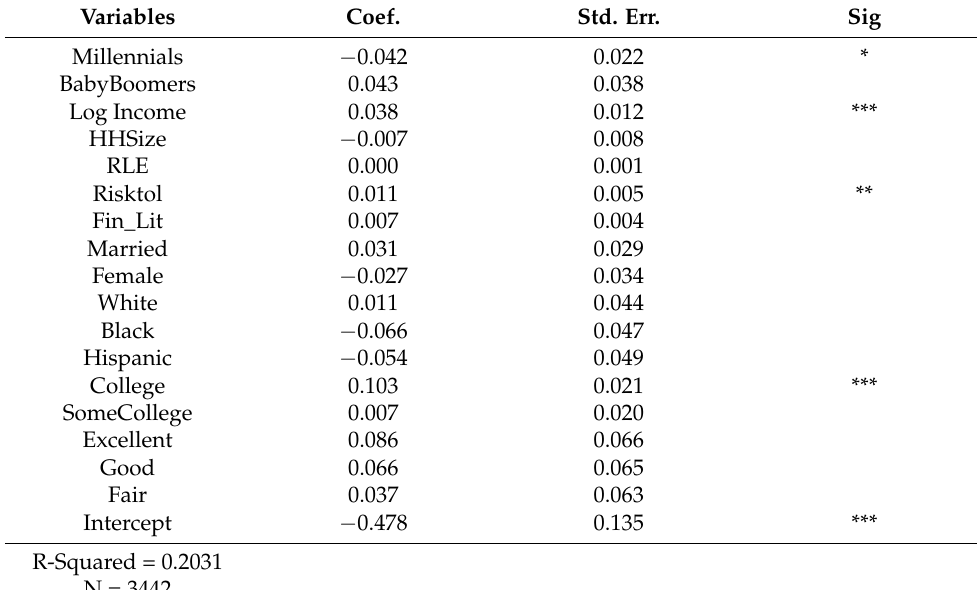
Table A6. Retirement Preparedness Estimation for Simulated 70–30 Allocation. Variables Coef. Std. Err.